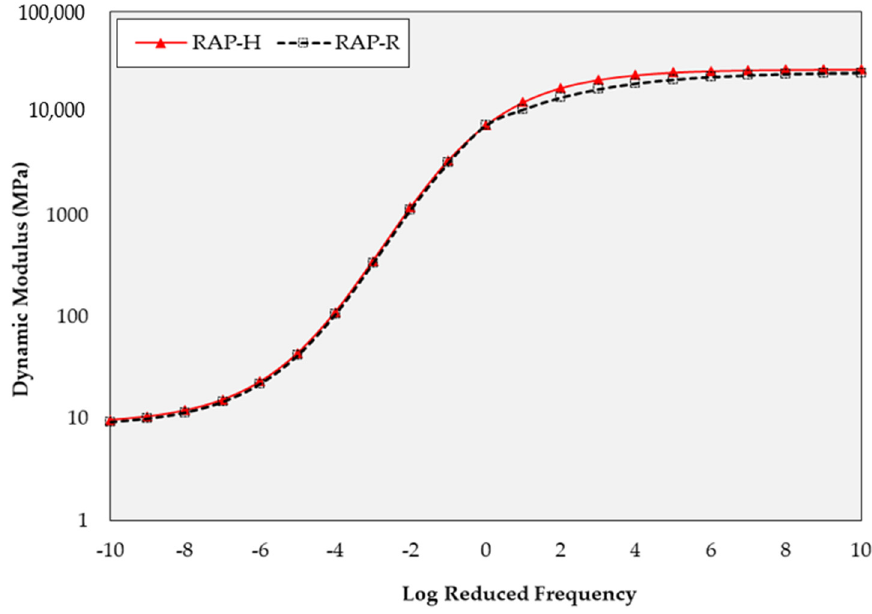
Figure 14. Dynamic modulus master curve of mixes RAP-H and RAP-R.